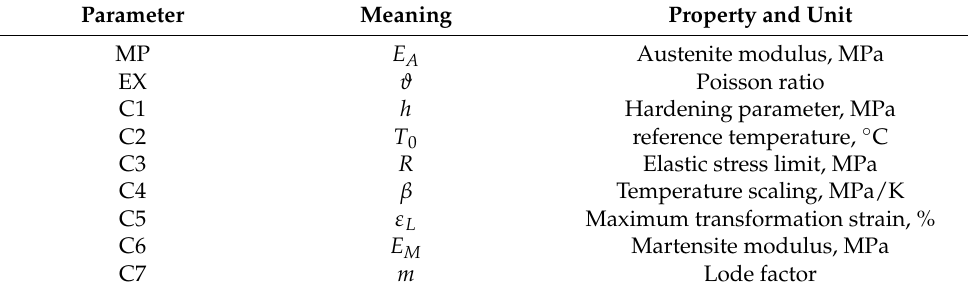
Table 4. SMA material model